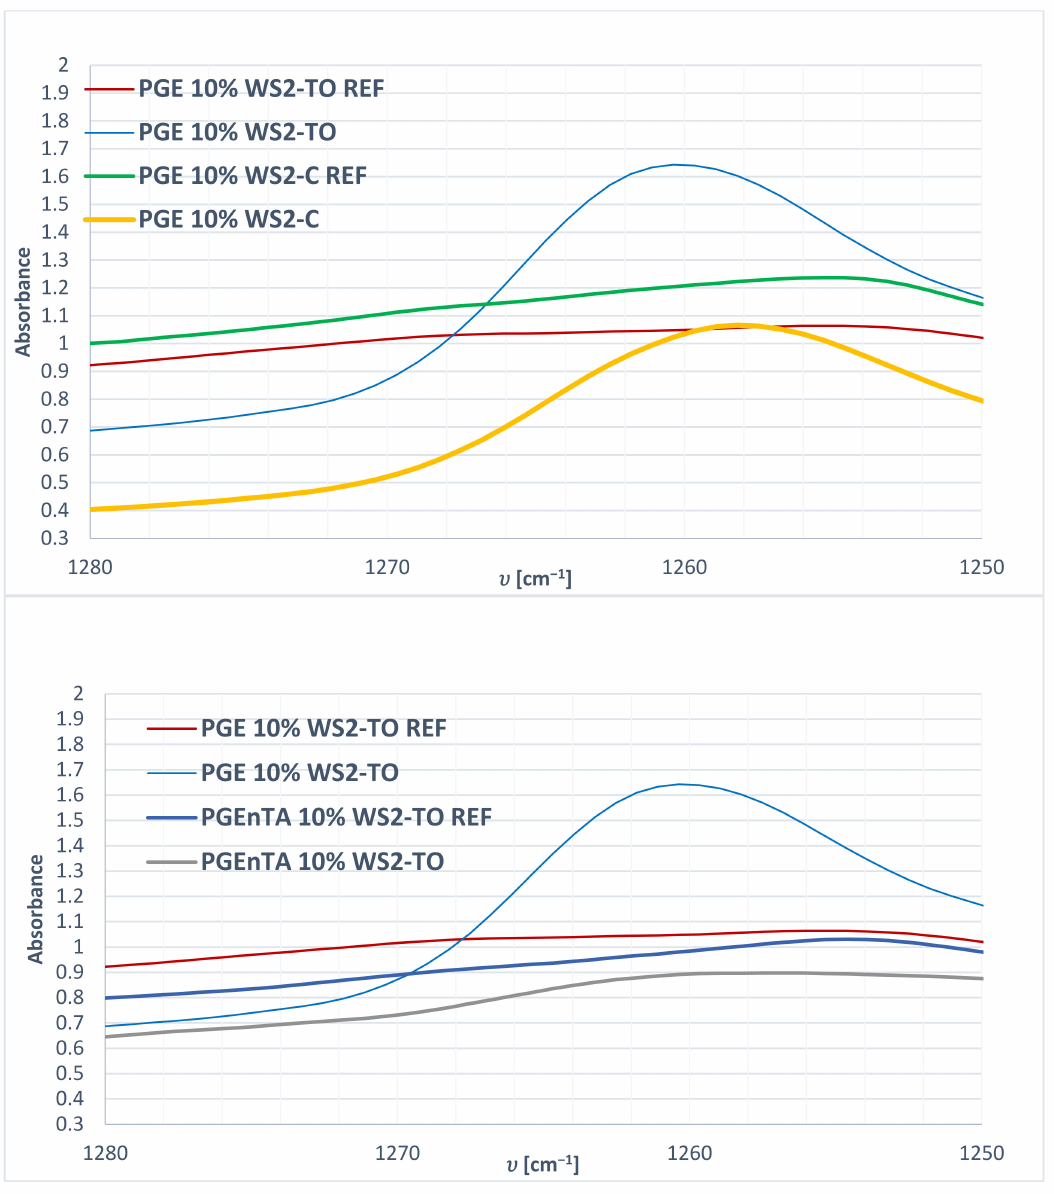
Figure 9. Expanded IR spectrum near the 1260 cm − 1 peak for 10 wt.% of WS 2 -TO and WS 2 -C in PGE ( top ) and for 10 wt.% of WS 2 -TO in PGE and PGEnTA. ( bottom ). REF refers to uncured